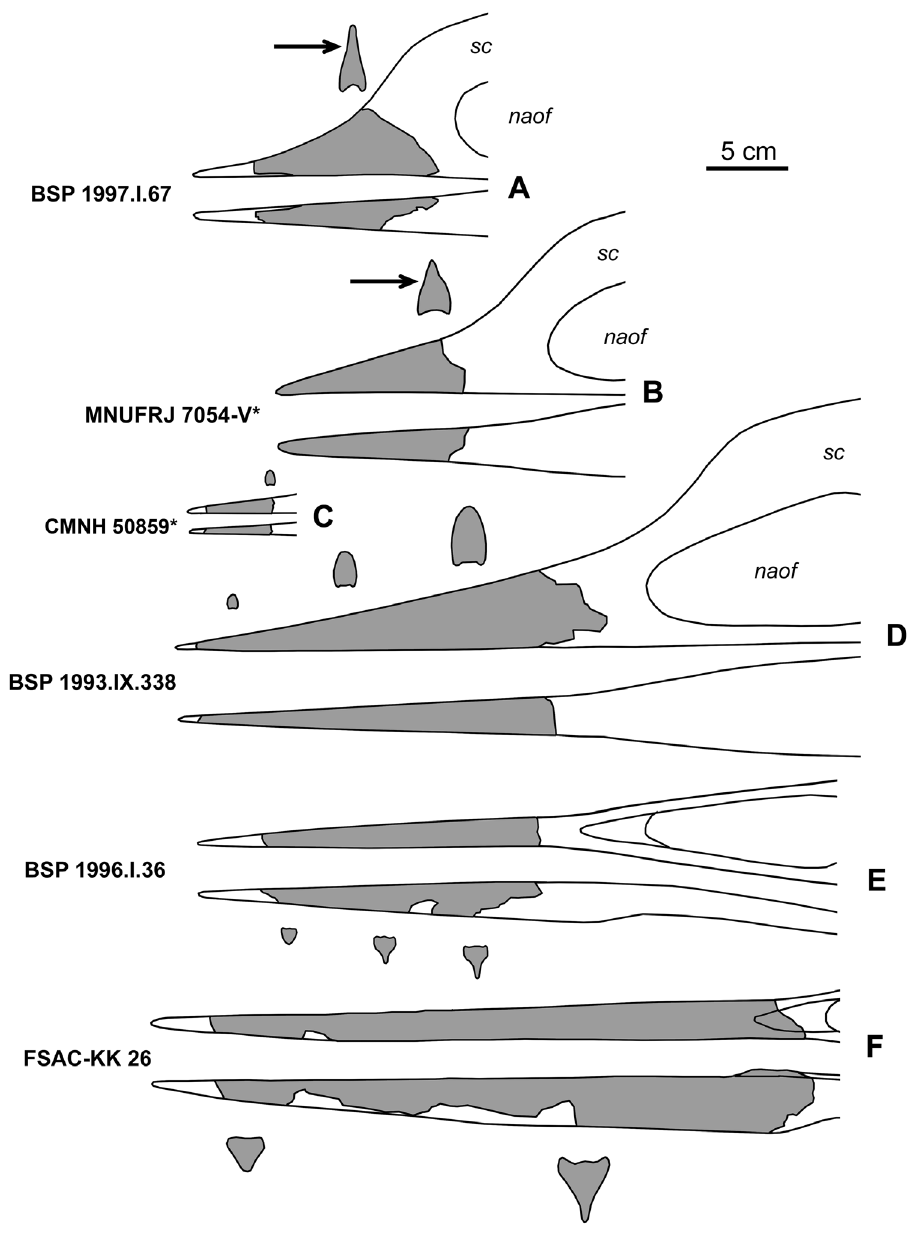
Figure 1. Ontogenetic interpretation of the known jaw fragments of Alanqa saharica (all drawn at the same magnification; specimen numbers are shown on the figure; reversed images are marked by asterisk). A–D rostrum fragments, in lateral and ventral views E, F fragments of mandibular symphysis, in dorsal and lateral views. Figures are modified from Wellnhofer and Buffetaut 1999 ( A, D, E ), Kellner et al. 2007 ( B ), Rodrigues et al. 2011 ( C ), and Ibrahim et al. 2010 ( F ). The arrow indicates the beginning of the sagittal crest on the cross sections of the rostra. Abbreviations : naof – nasoantorbital fenestra; sc – sagittal